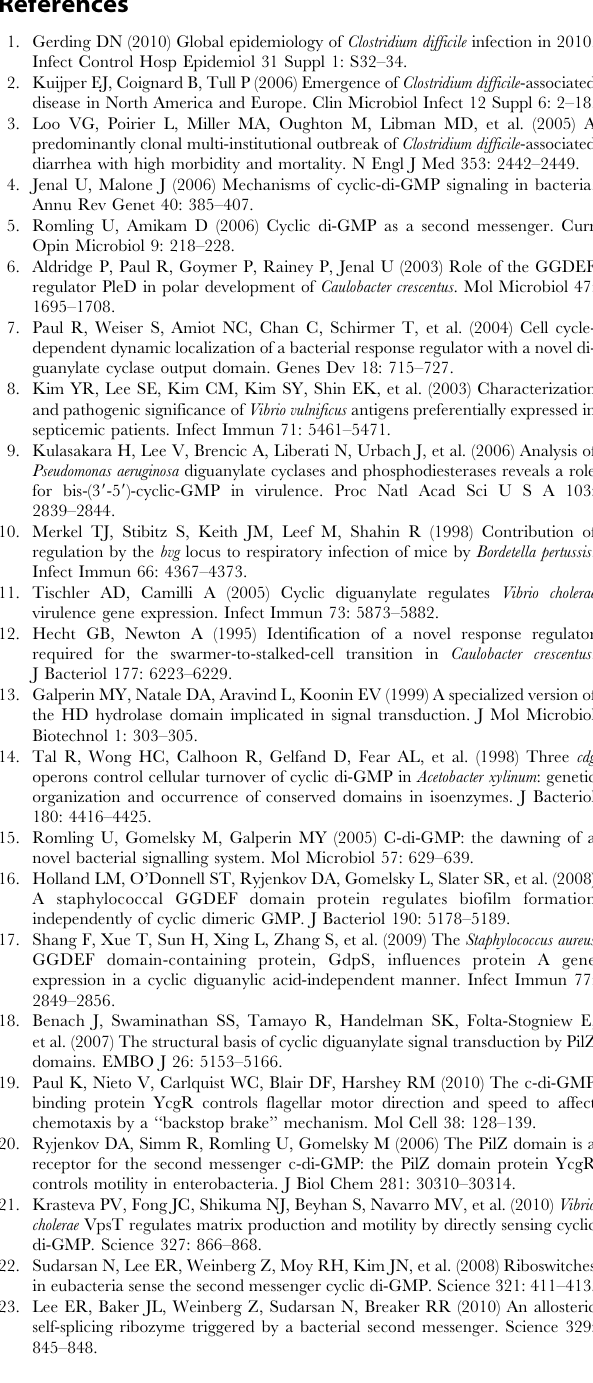
Table S5 DNA sequences of the oligonucleotides used in this study. (DOC) Text S1 Supplemental Materials and Methods.